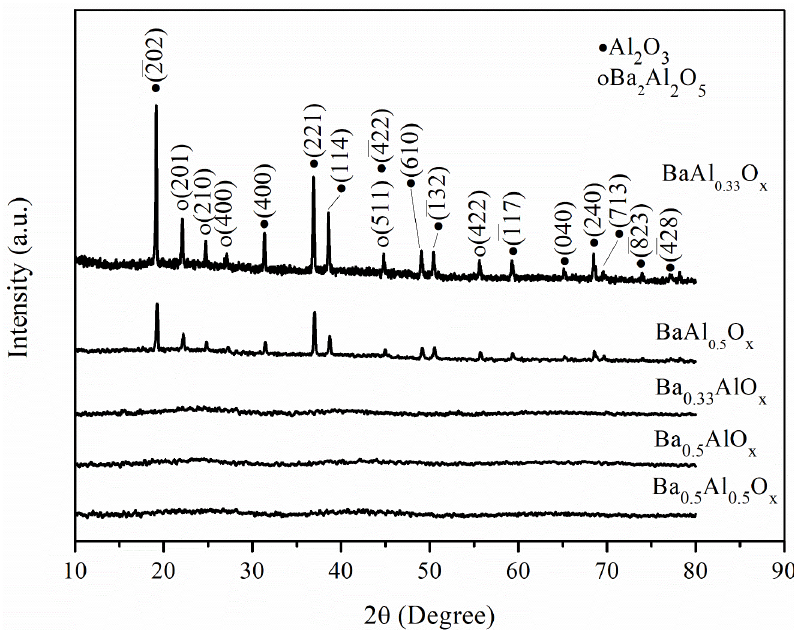
Figure 6. XRD of various BaAlO x powders prepared at different ratios of Ba and Al contacts.